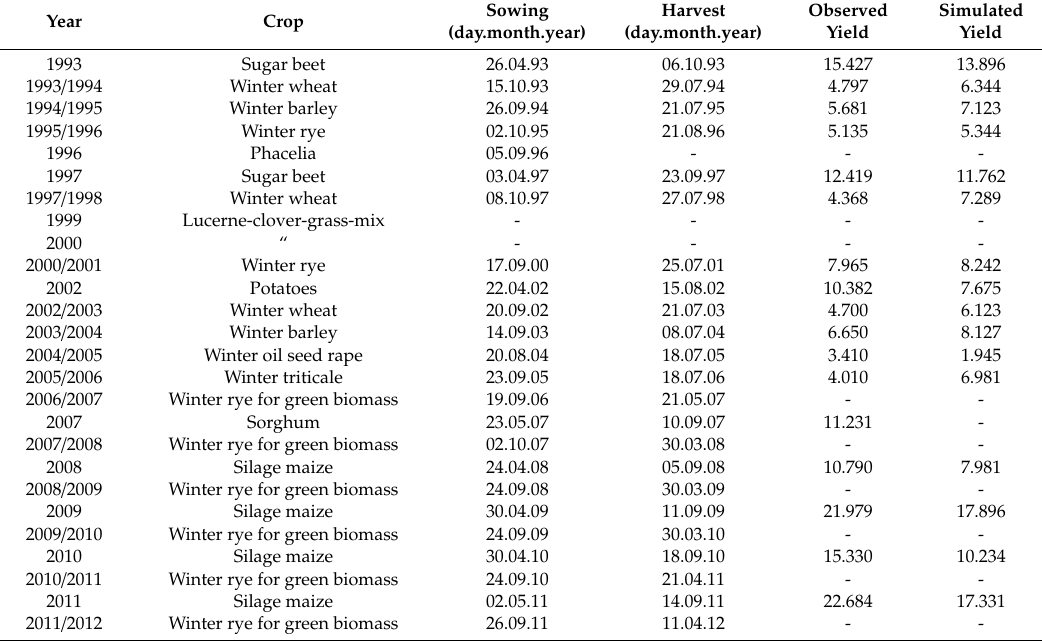
Table A3. Crop rotation, sowing date, harvest date, and yield (t ha − 1 ), Plot 3 ([38], modified). Year Crop